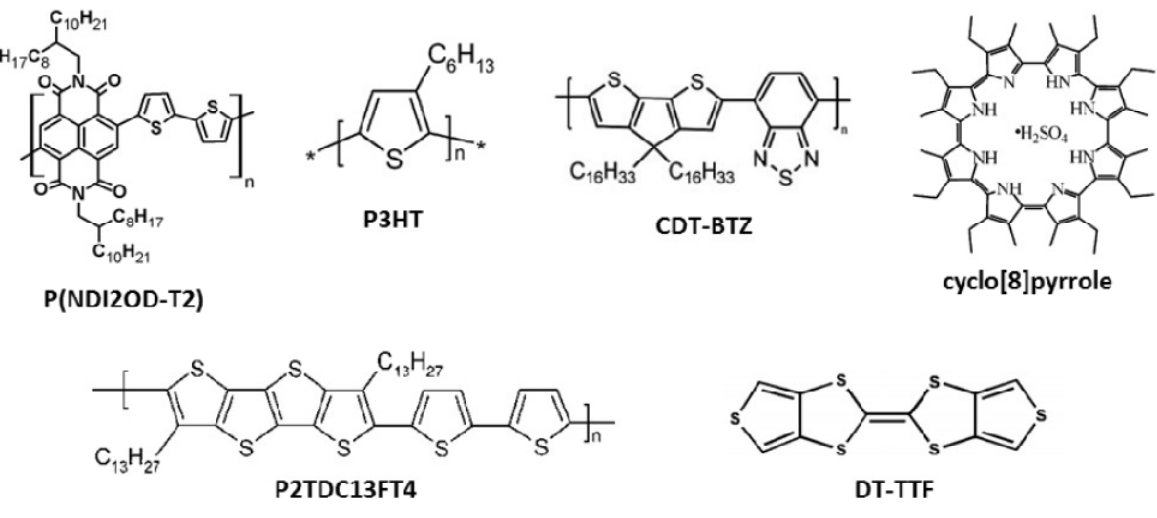
Figure 2. Molecular structures of materials used in organic thin film field-effect transistors (OFETs) reported as examples in this review.